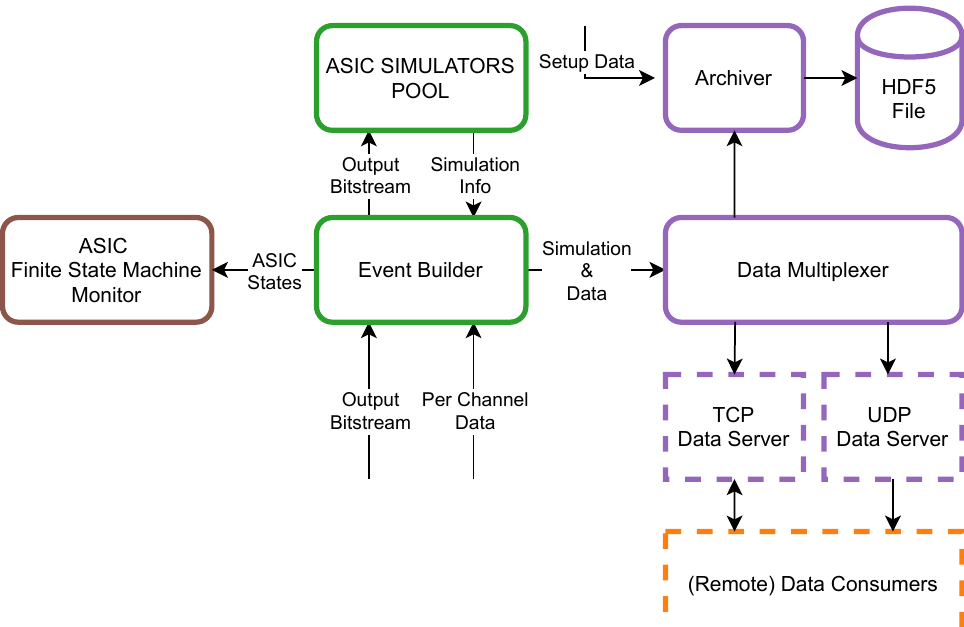
Figure 8. Per Channel Data distribution diagram. Acquired data and the corresponding Output Bitstream are put together by the Event Builder thanks to the ASIC Simulators Pool which programmati- cally simulate (1) state of each ASIC (2) and stimulation waveforms. Per Channel Data and simulated stimulation waveforms are then saved into the file and can be broadcasted by TCP/UDP Data